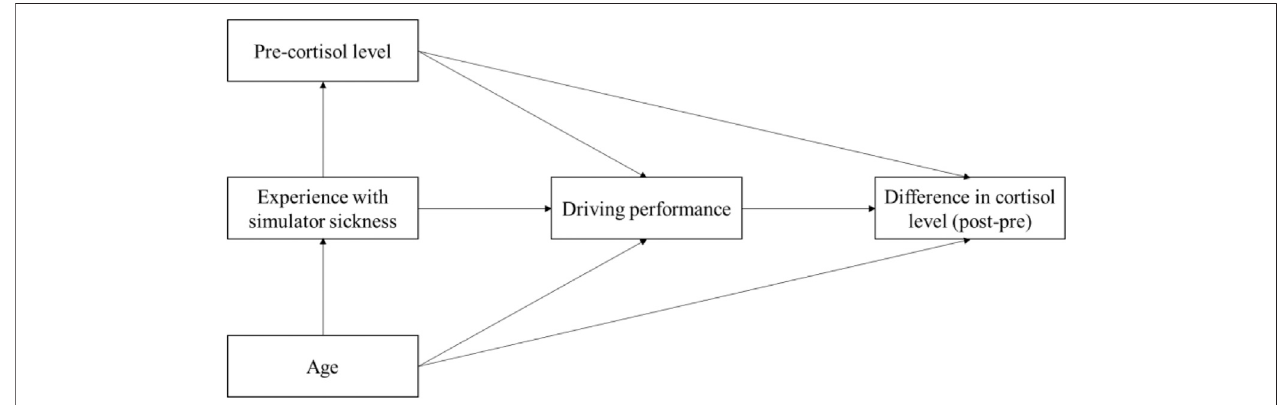
FIGURE 1 | The hypothetical model of stress, experience with simulator sickness, and